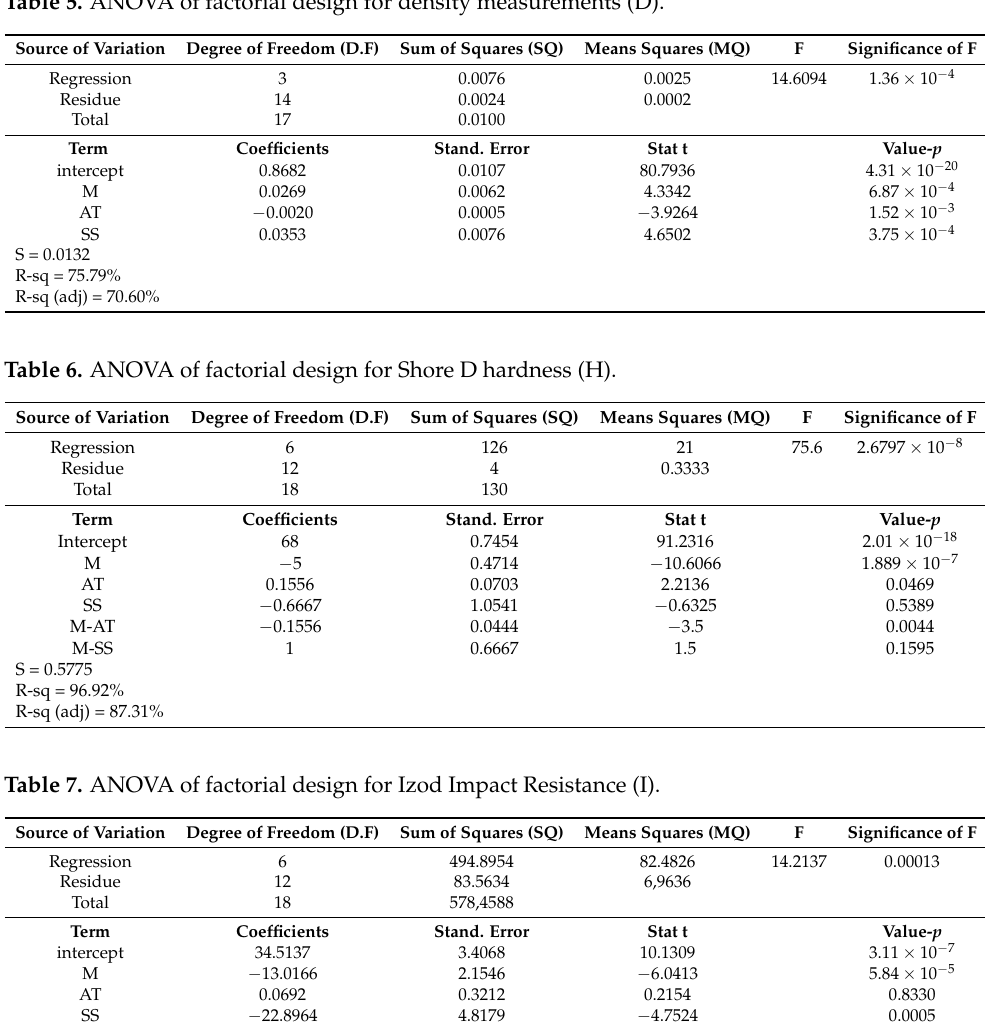
Table 5. ANOVA of factorial design for density measurements (D).